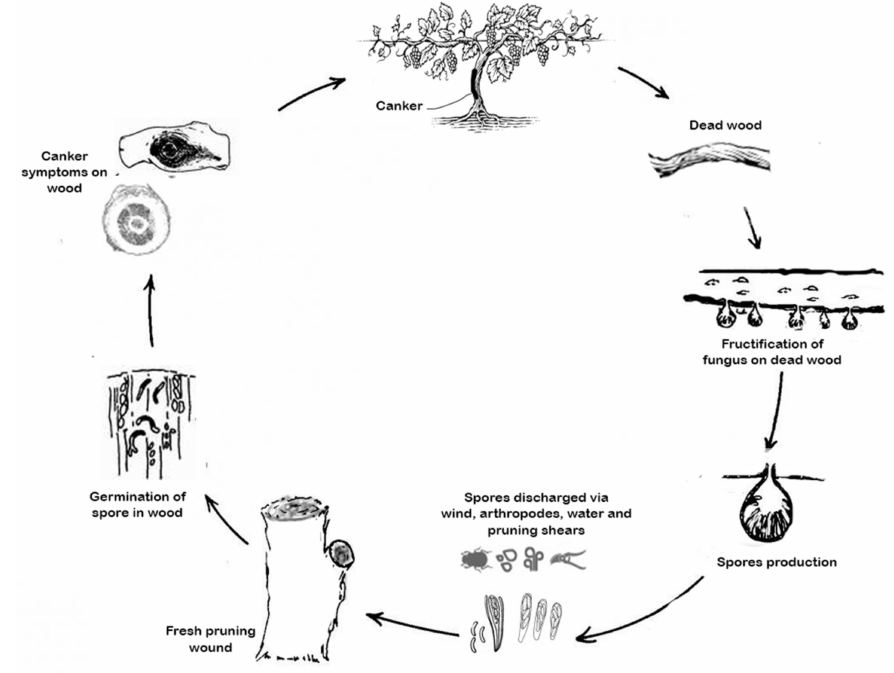
Figure 3. The life cycle of the fungus causing grapevine trunk